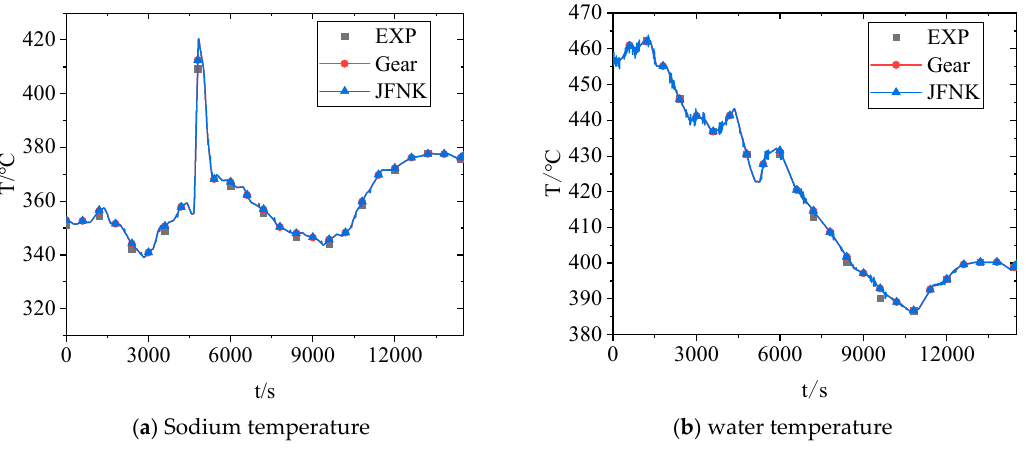
Figure 6. ETEC shutdown experiment transient outlet temperature comparison.